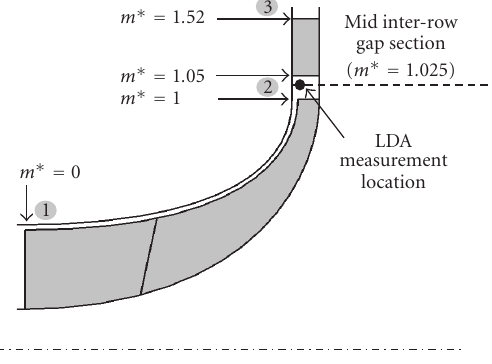
Figure 2: Meridional view of the compressor stage.